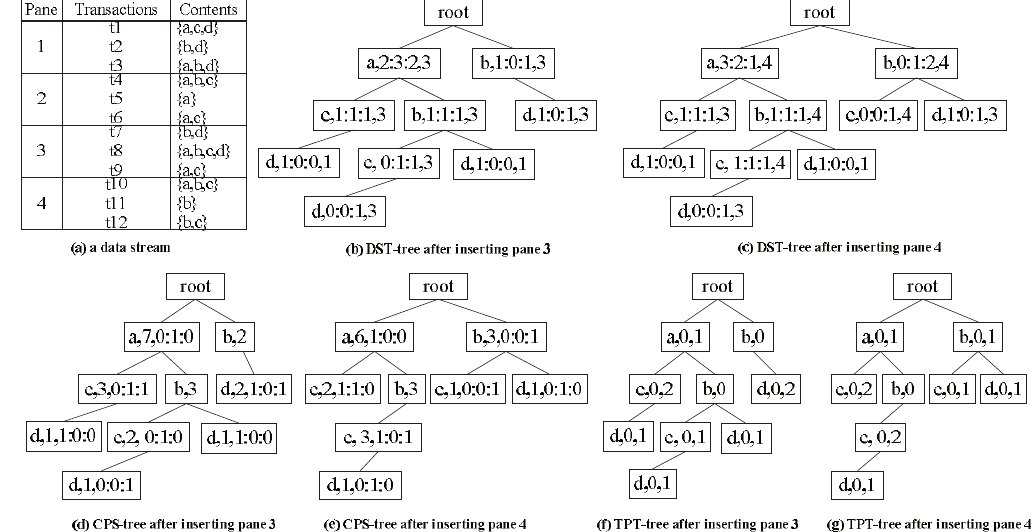
Fig. 4. A simple case study of the TPT